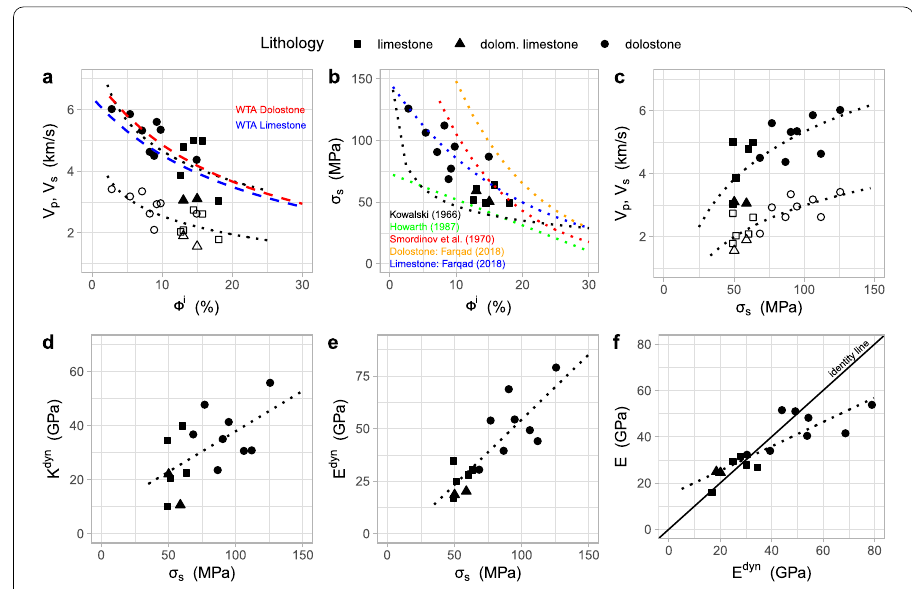
Fig. 6 Geomechanical characterization of the tested sample material. a Dynamic velocity measurements of the compression wave v p (black) and shear wave v p (white) show a distinct decrease in velocity with increasing initial porosity Φ i (WTA Wyllie Time Average). b Rock strength σ s is negatively correlated with the = initial porosity Φ i and implies a decrease in rock strength with increasing porosity. Several authors published a similar dependency of both parameters based on empirical data. c Wave velocities show an exactly inverse correlation with rock strength, again with a direct relationship through porosity. The dynamic bulk modulus K E dyn ( d ) and the dynamic Young’s modulus dyn ( e ) are both positively correlated with the rock strength, indicating increasing stiffness and elasticity of the rock with increasing rock strength. f Results for the dynamic ( E dyn ) and static ( E ) Young’s modulus show a general similarity. However, the measured values for samples with abundant vugs show significantly higher values for E dyn , as most of the separated vugs cannot be detected by ultrasonic